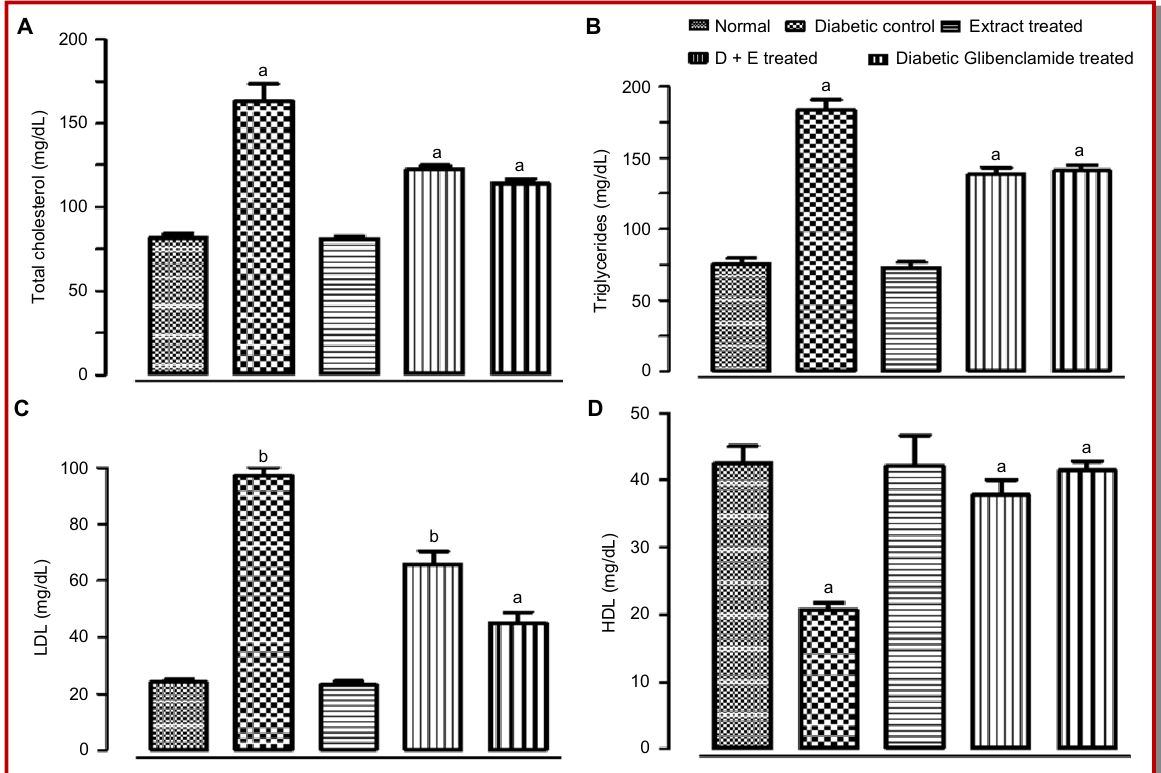
Figure 1: Effect of extract and standard drug on total cholesterol (A), triglycerides (B), LDL (C) and HDL (D) levels of normal and alloxan-induced diabetic mice. Data represented as mean ± SD values of 6 animals each a p<0.001, b p<0.05 (One-way ANOVA, Dunnet’s t - test, GraphPad Prism software); “D + E” means extracted -treated in diabetic